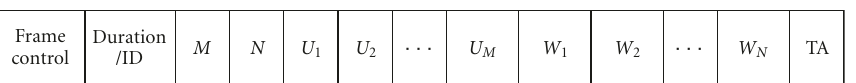
Figure 2: Multipolling frame